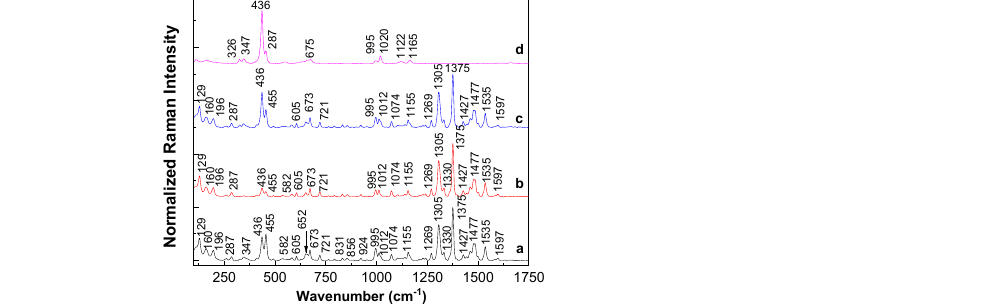
mixture of 25 wt.% ( a ), 50 wt.% ( b ) and 75 wt.% ( c ), and ST ( d ). ture of 25 wt.% ( a ), 50 wt.% ( b ) and 75 wt.% ( c ), and ST ( d ).